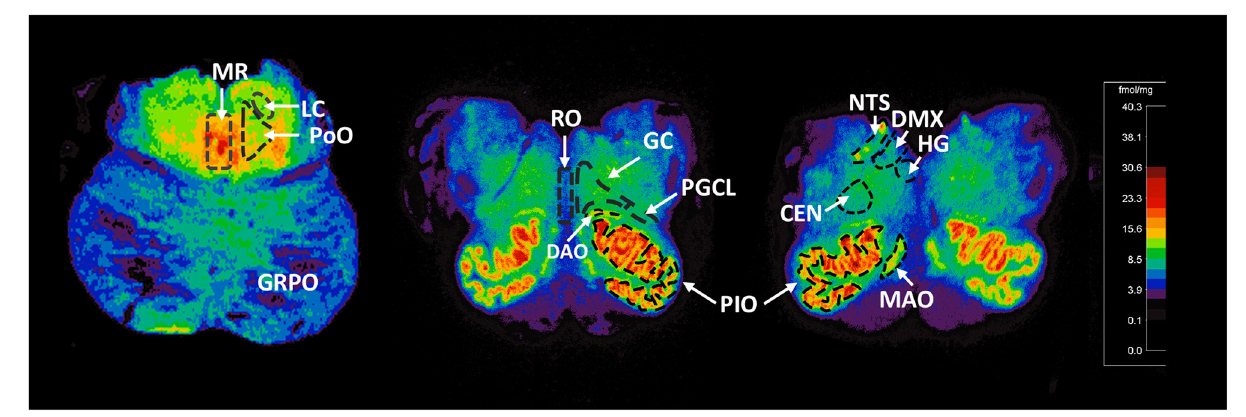
FIGURE 1 | Representative distribution of 125 I-epibatidine binding in the pons and medulla. Illustrative autoradiograms displaying 125 I-epibatidine binding in tissue sections at the level of the pons (left), rostral medulla (middle), and mid medulla (right). Sections are taken from a 52-postconceptional week SIDS case (pons) and a 45-postconceptional week SIDS case (rostral and mid medulla) case. Receptor binding is normalized to the same scale (shown). The amount of receptor binding in fmol/mg is indicated with color according to the scale. The nuclei measured are denoted with dashed boundary lines and labeled. These nuclei include the